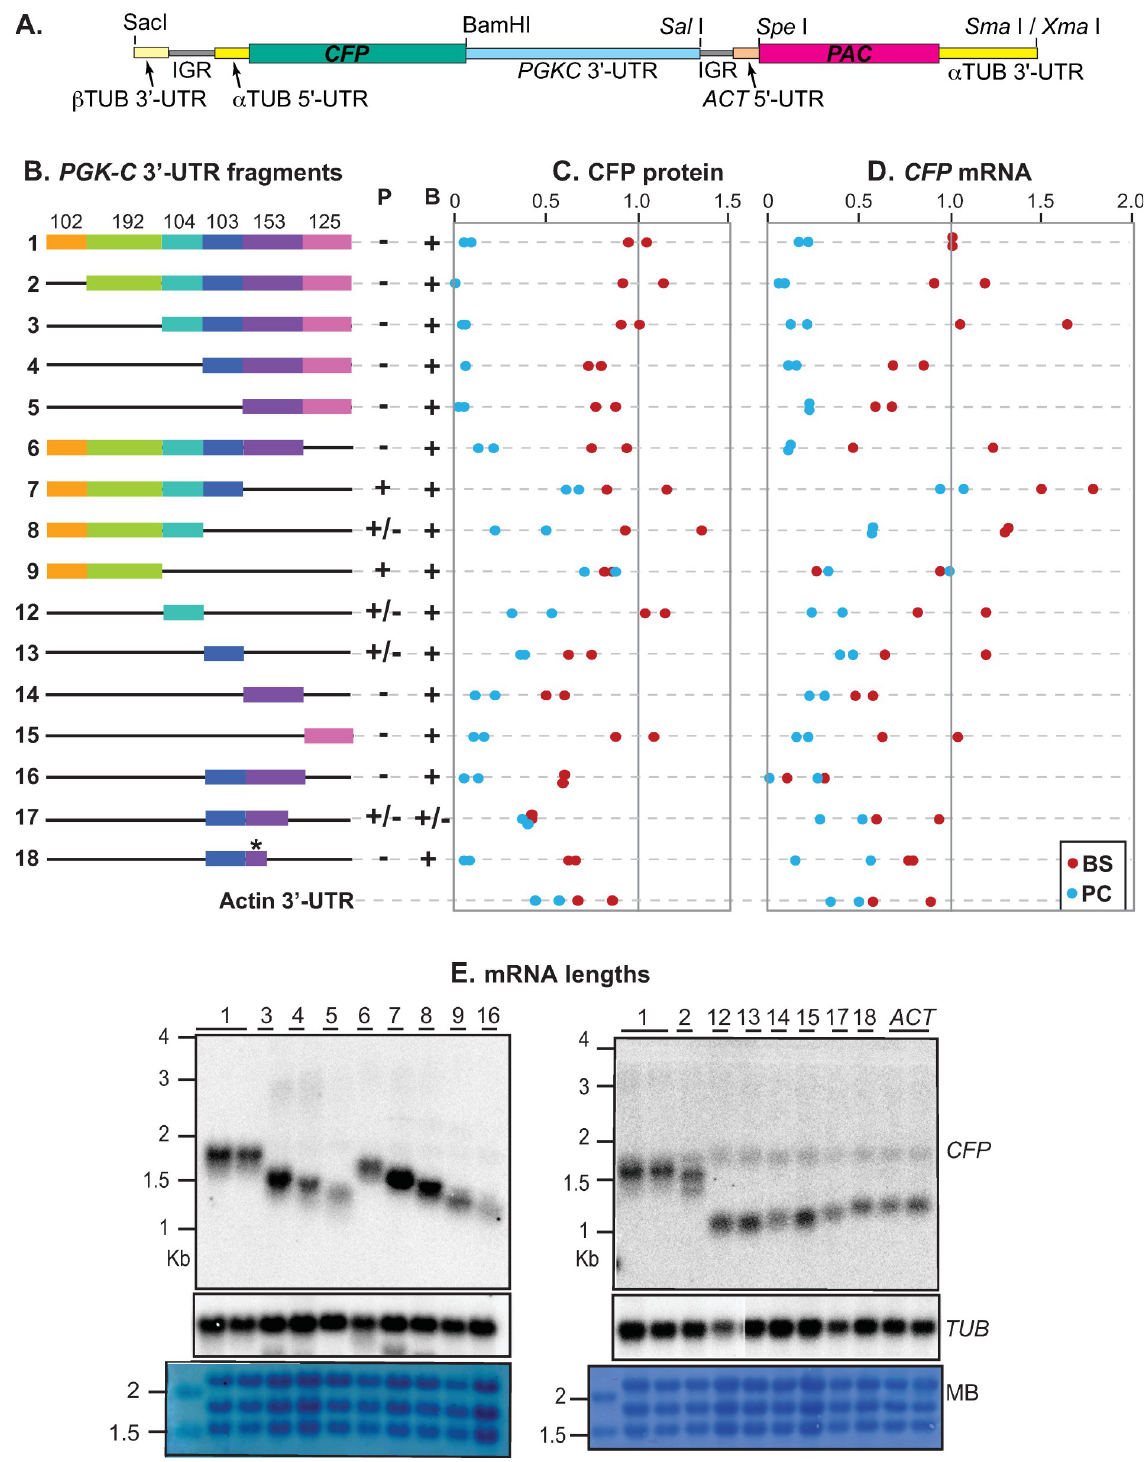
Fig 3. The PGKC 3’-UTR contains at least two regulatory sequences. A. Cartoon showing one of the CFP reporter constructs (pHD3261) used in this study. Different fragments of the PGKC 3’-UTR were cloned downstream of the CFP reporter coding sequence. The polyadenylation site "p (A)" is specified by the PAC splice signal. TUB denotes the tubulin locus. ACT denotes actin. B. Schematic diagram of the PGKC 3’-UTR segments used to map the regulatory sequences. Measurements are on the right. Each dot is a result for an independent clone, with red and blue representing bloodstream (B) and procyclic (P) forms, respectively. Protein levels were estimated from Western